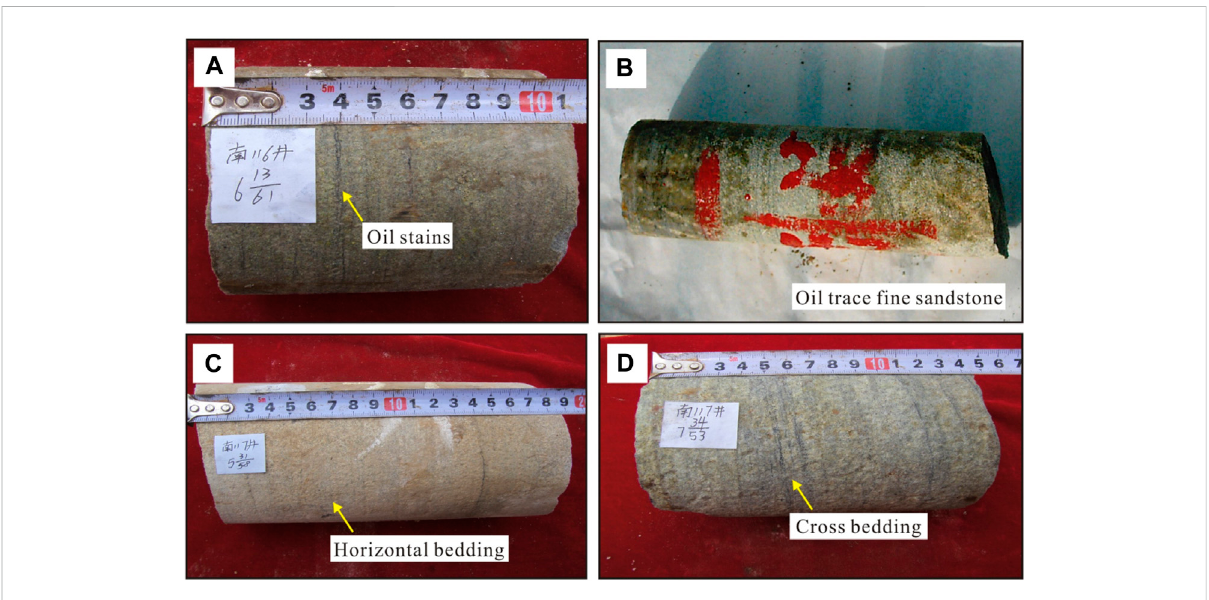
FIGURE 3 Core images of the Chang 1 Member sandstones in the study area. (A) Light gray oil traced fi ne sandstone, Well Nan116, 711.96 – 712.06 m; (B) Gray oil trace fi ne sandstone, Well Xi63, 726.31 – 726.57 m; (C) Parallel bedding, Well Nan117, light gray fi ne sandstone, 714.26 – 714.44 m; (D) Cross